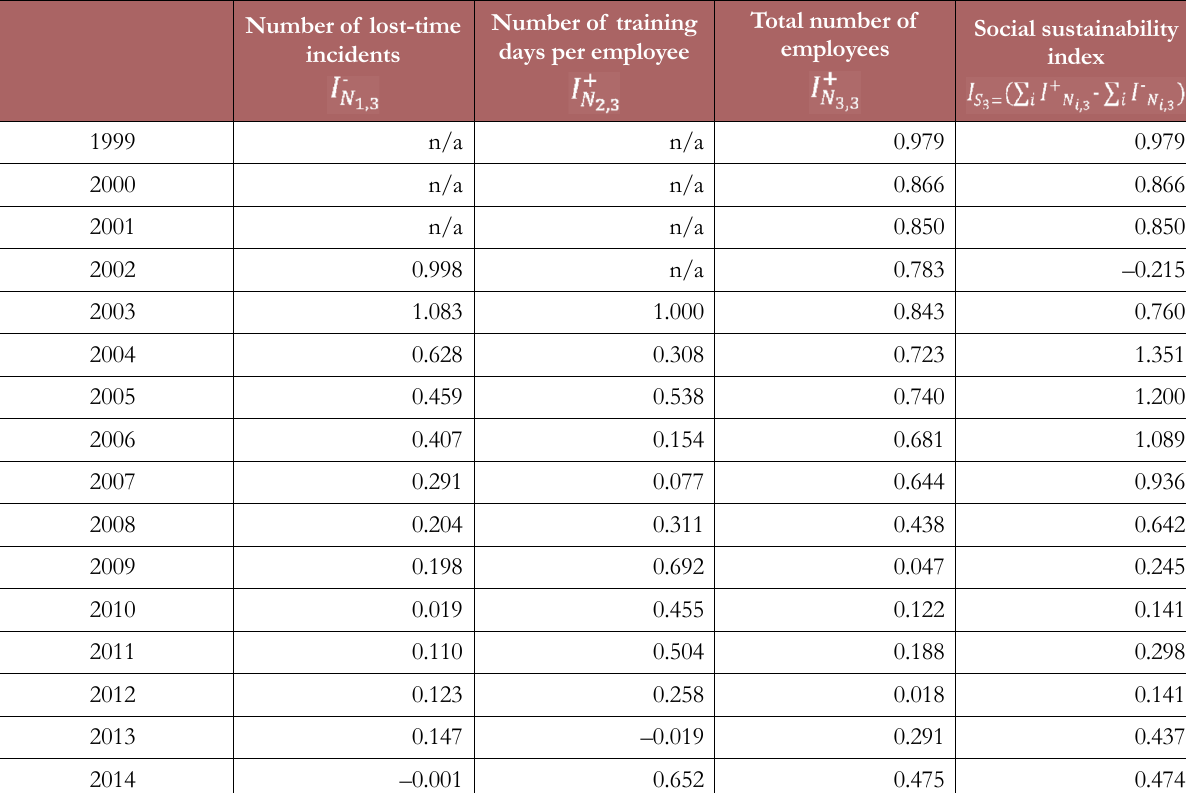
Table 7. Determination of the social sustainability